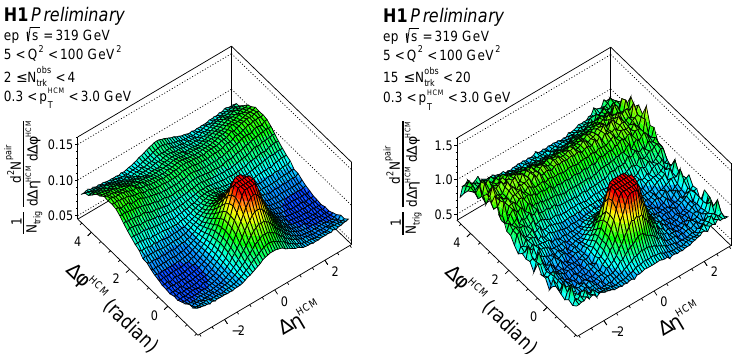
(cid:112) s = 319 GeV, referring to 2 ≤ N obs